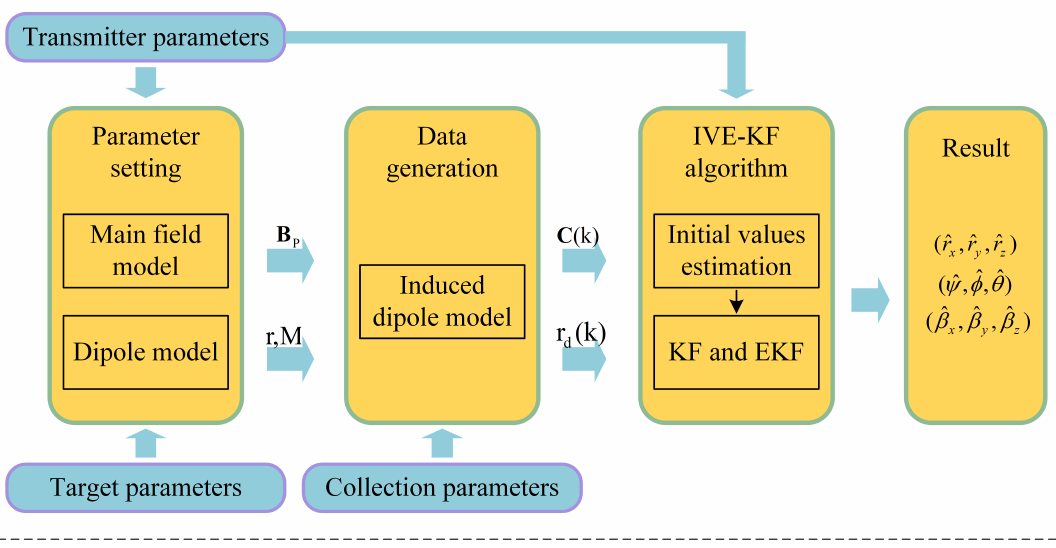
Figure 5. EMI simulation system diagram. Table 2. Transmitter simulation parameters and default values.